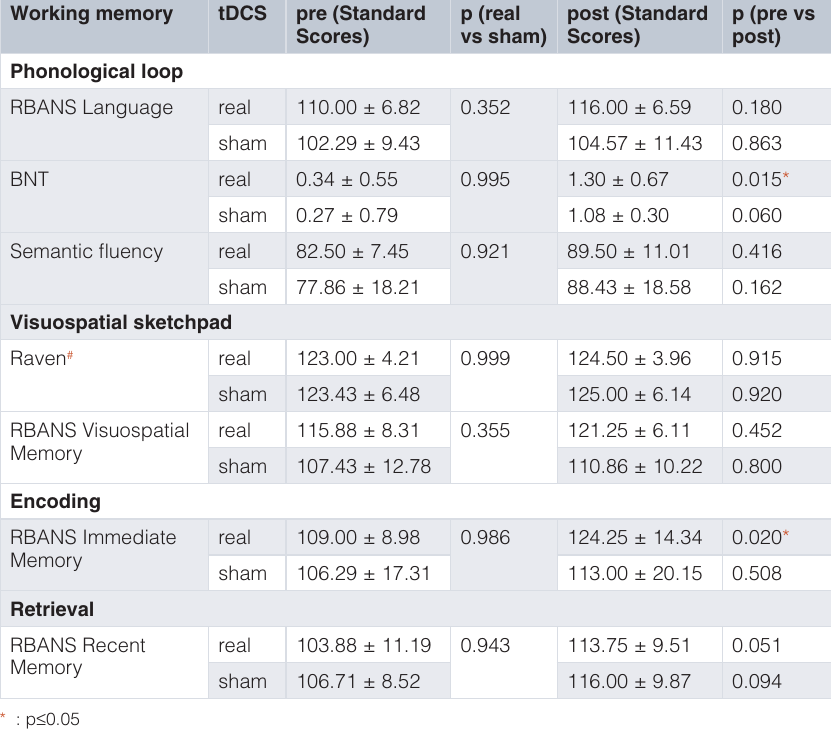
Table 6. Pre- and postscores and p-values of the post-hoc analyses of the other working memory components per